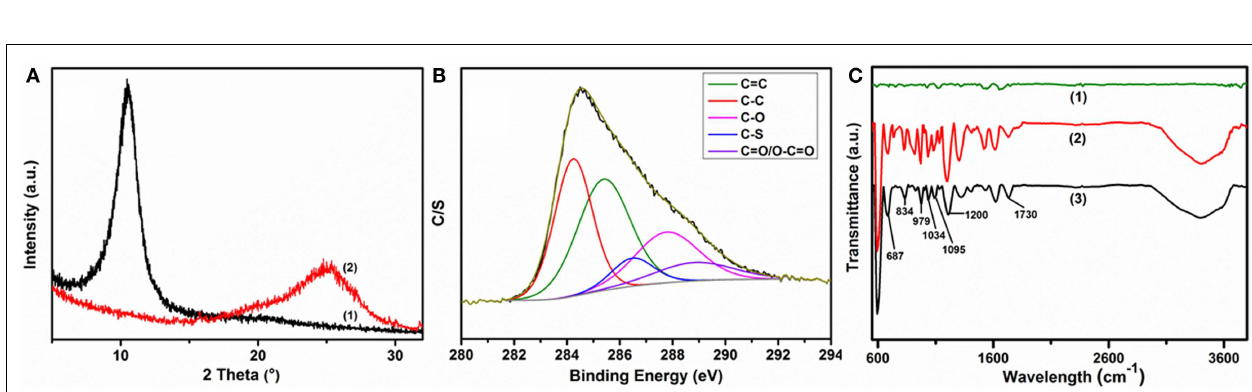
FIGURE 4 | Structural characterization of composites: (A) comparison of XRD patterns of as-prepared composites: (1) GO, (2) GO-PP 25, (3) GO-PP 50, and (4) GO-PP 75; (B) XPS survey spectra of (1) GO, (2) GO-PP 25, and (3) rGO–PP 25 composites; and (C) fitted GO-PP 25 composite core level spectrum in the carbon region .